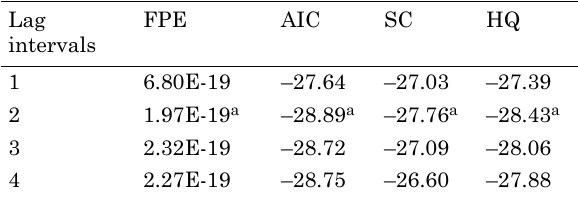
Table 5. VAR lag order selection